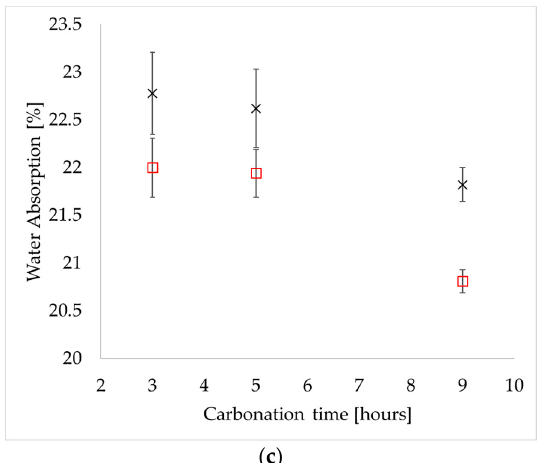
Figure 7. Average values of physical properties in difference CO 2 pressure (× 1 bar and □ 3 bar CO 2 pressure): ( a ) Apparent void volume (AVV); ( b ) bulk density (BD) and ( c ) water absorption (WA).